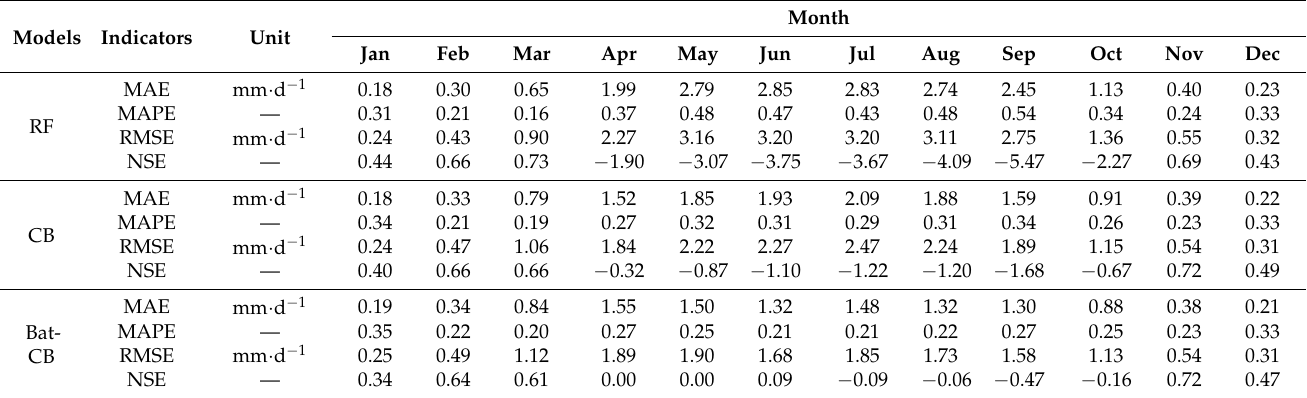
Table 3. Monthly average values of statistical indicators generated from the three machine learning models during the testing